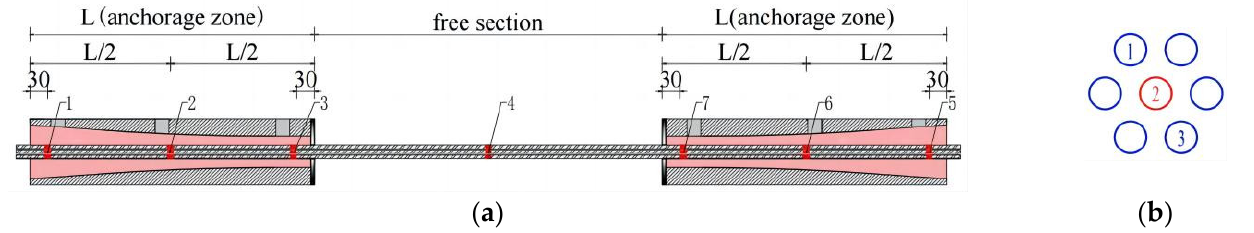
Figure 4. Measuring points arrangement of anchorage system: ( a ) longitudinal arrangement; ( b )